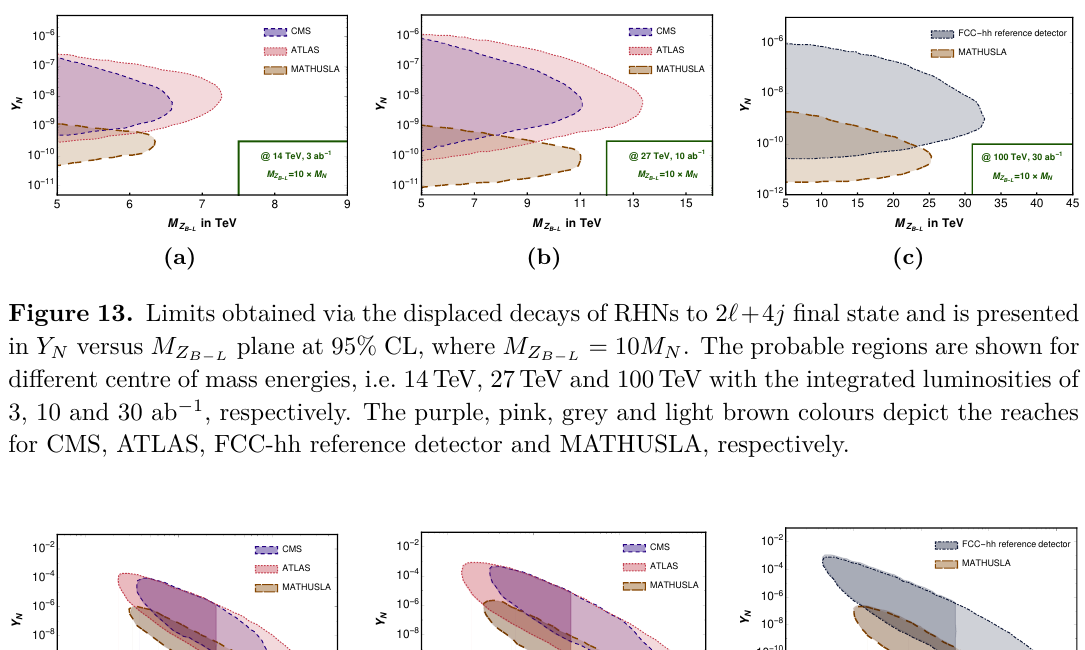
versus M plane at N N